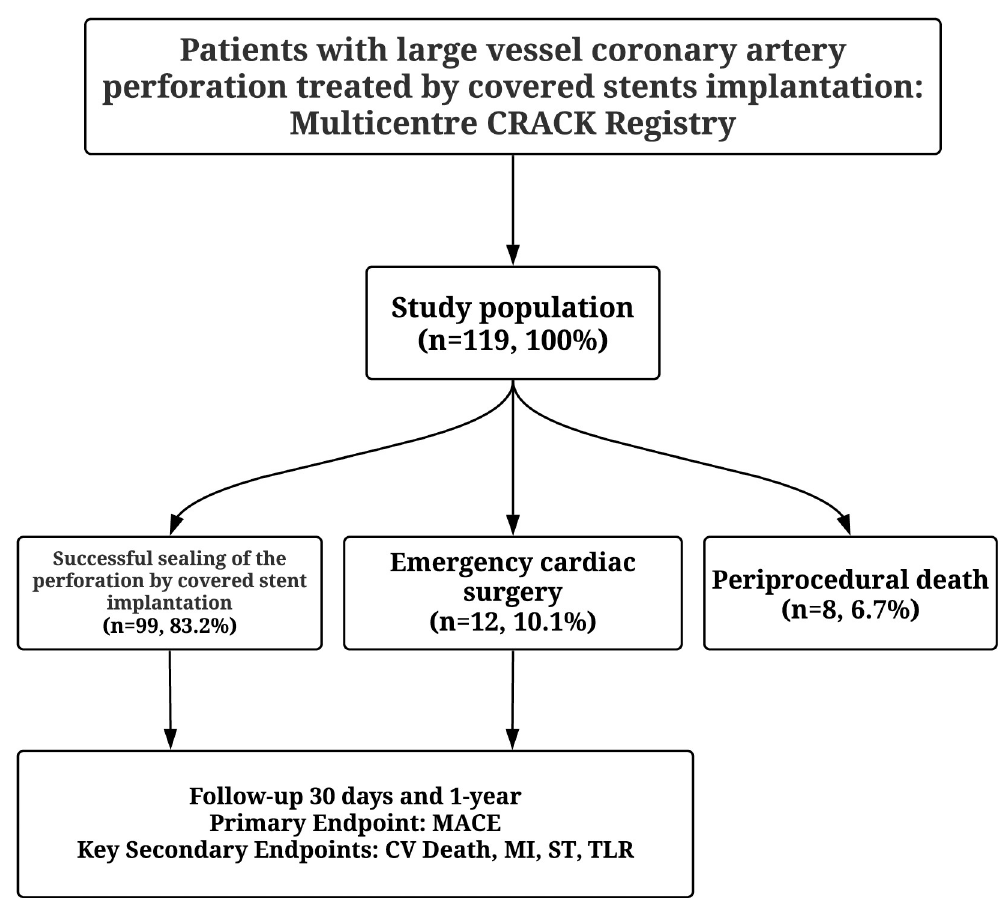
Fig 1. Study flow chart. PCI—percutaneous coronary intervention; CV- cardiovascular; MACE- major adverse cardiac events; MI- myocardial infarction; ST- sent thrombosis; TLR- target lesion revascularization.